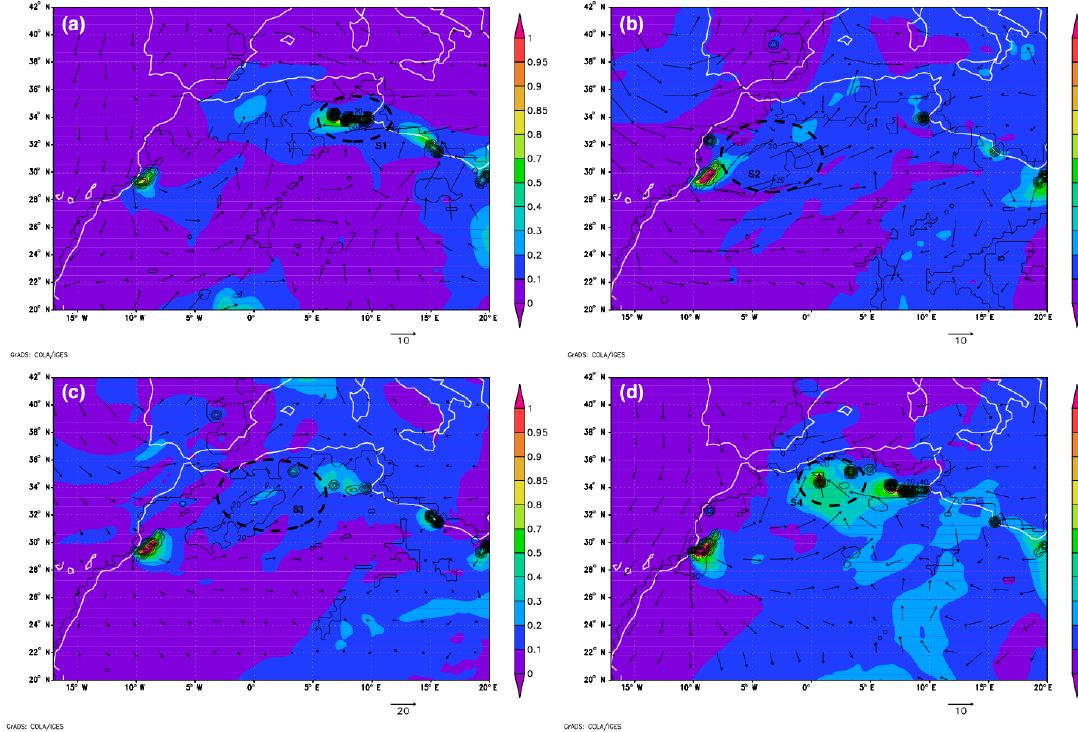
Figure A1. As in Fig. 4 except that the S11 rather than the S01 configuration is used.